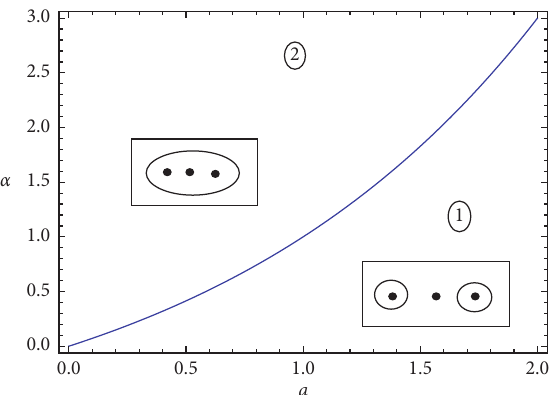
Figure 3: Melnikov threshold curve of the unperturbed model and the qualitative branching at b �